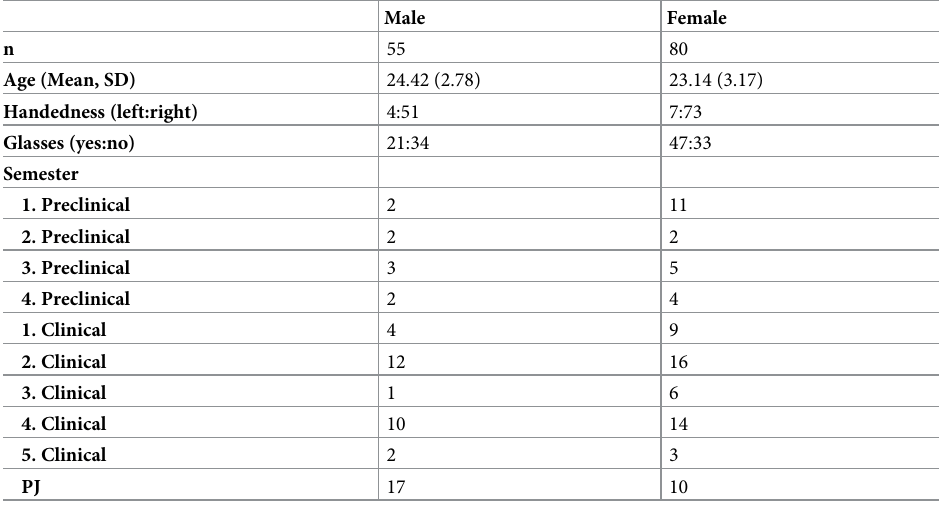
Table 1. Demographic